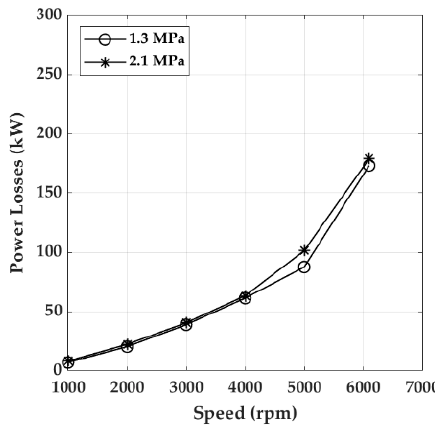
Figure 23. Flooded Rocker Pivot bearing pad power losses.